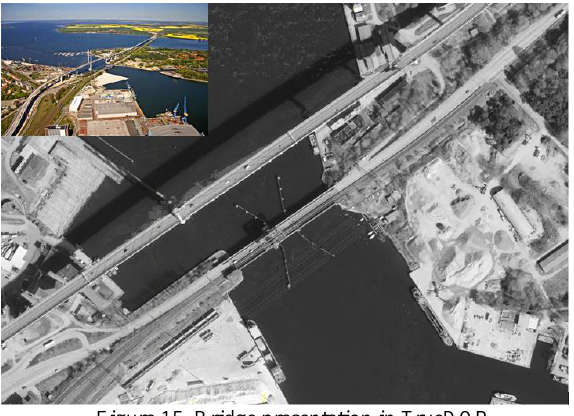
Figure 15. Bridge presentation in TrueDOP